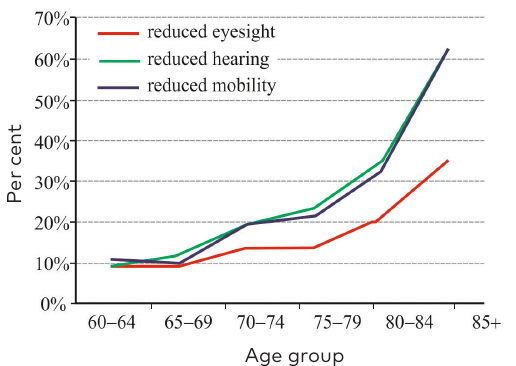
Figure 3. Physical impairment, Netherlands (Daniel, Pokriefke, & Risser,